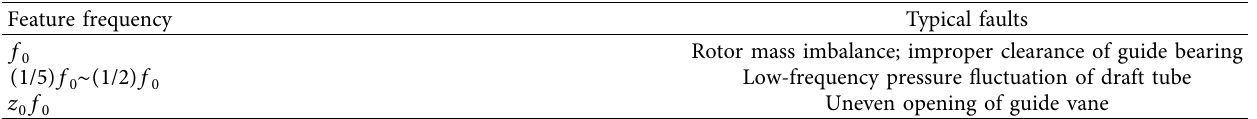
Figure 9: Actual signal processed by GA-SR-FDM. (a) Y -direction swing signal of the flange. (b) Signal at the draft tube. Table 2: Partial vibration fault characteristics of hydropower